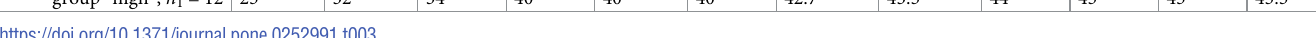
Table 3. Data for the anchoring example in 1,000 feet. group “low”, n 0 = 8 2.3